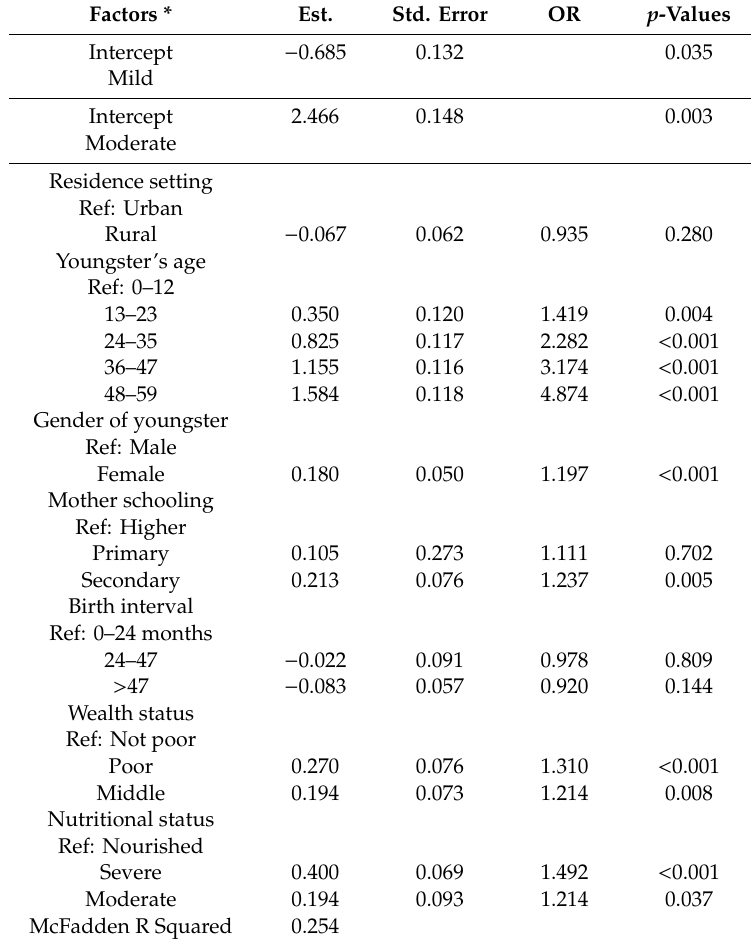
Table 4. Covariates parameter estimates and Odds ratio using the pooled sample.